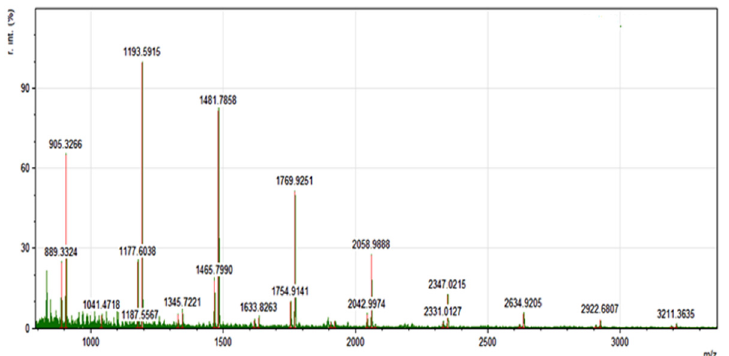
Fig 2. MALDI-TOF mass spectrum of the aqueous fraction residue from ASE. The spectrum was obtained on a Bruker Autoflex Speed; DHB matrix, 1:1:10 (sample: NaCl:matrix). Mass peaks are of sodium adducts of B-type proanthocyanidins: [M + Na] + m/z = 889, 903, 1177, 1193, 1465, 1481, 1753, 1769, 2041, 2058, 2329, 2347, 2617, 2634, 2907, 2922, 3193 and